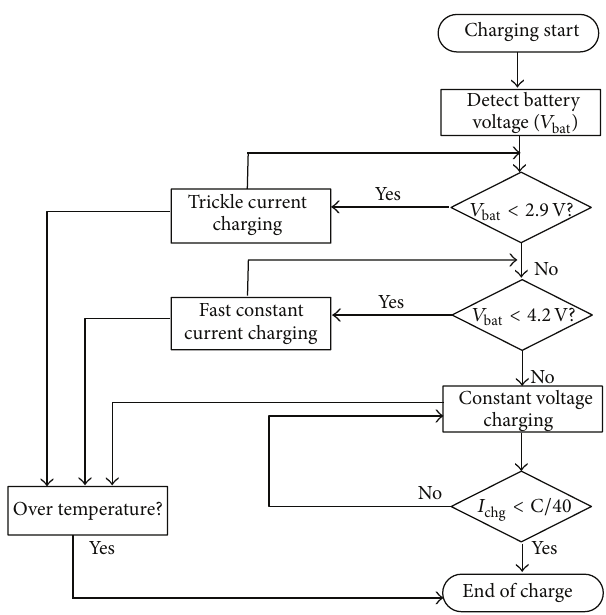
Figure 2: Battery charging